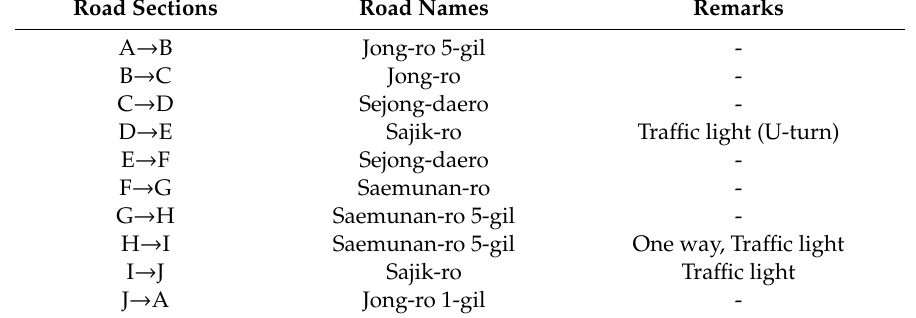
Table 1. Summary of observation roads during the BBMEX campaign.